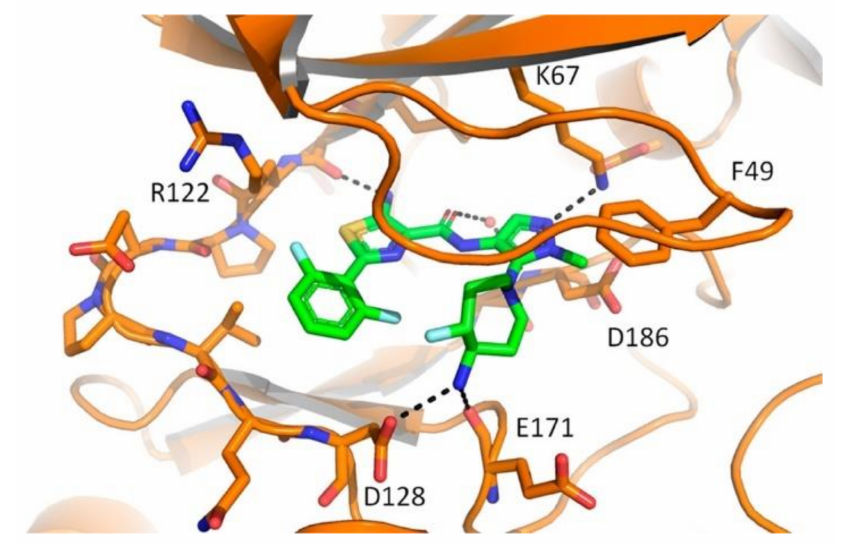
Figure 69. In silico binding interactions of compound 63 with Pim1 crystal structure